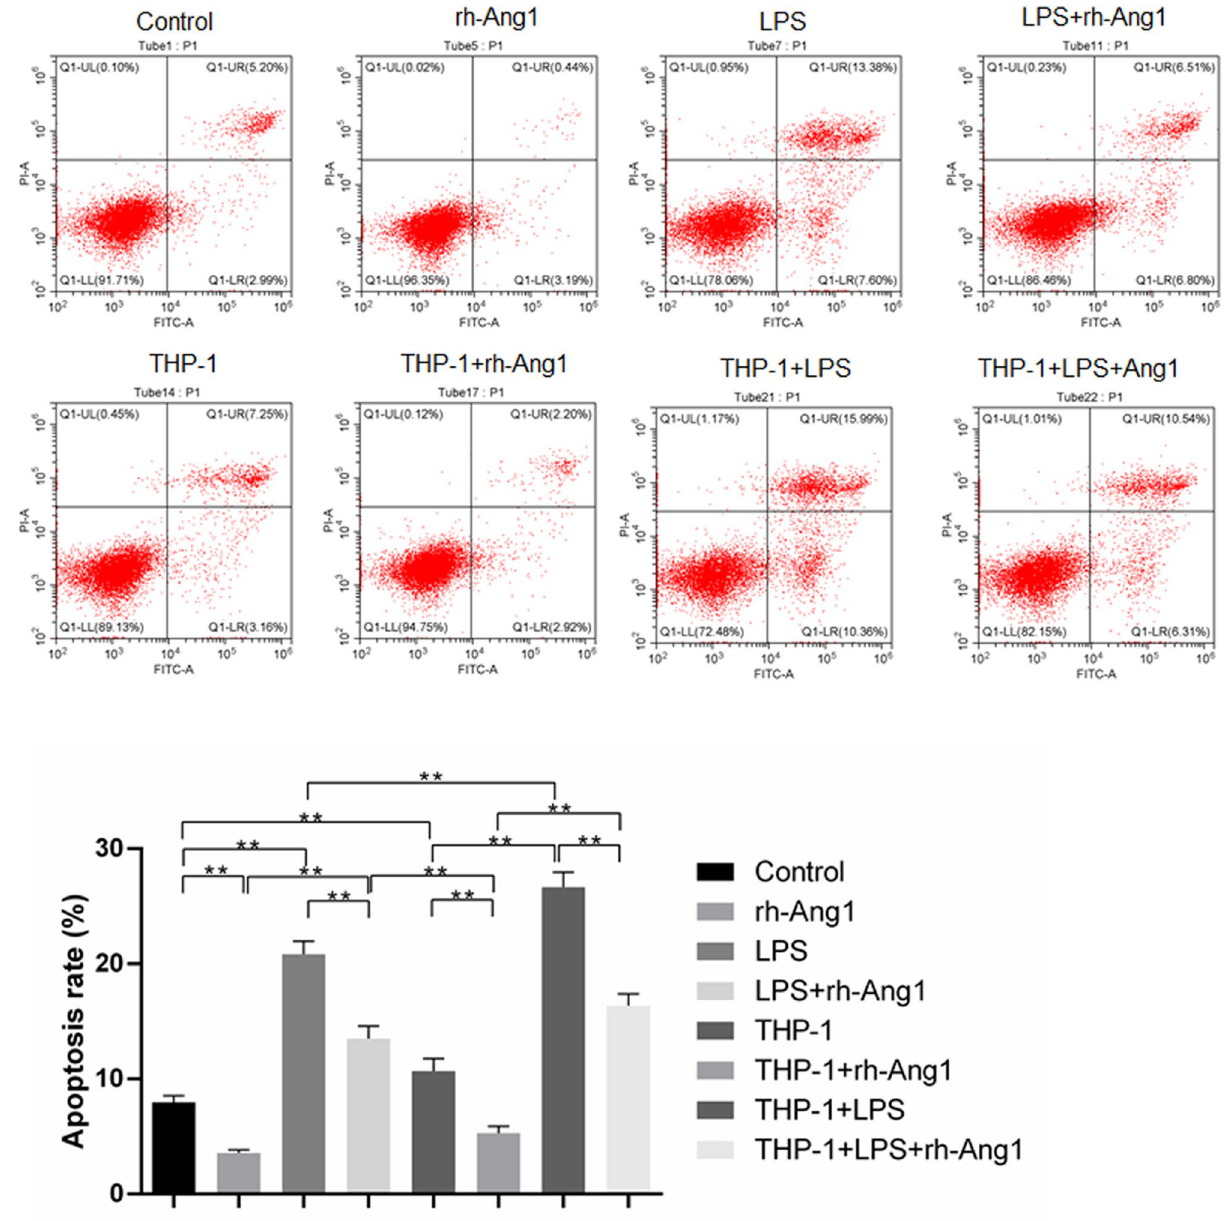
Figure 8. Ang1 significantly attenuated apoptosis of HUVECs under various conditions. Ang1 were used as a final concertation of 250 ng/mL. HUVECs were cultured alone with/without LPS (100 μg/mL) for 8 h, or co-cultured with THP-1-derived macrophages with/without LPS (100 μg/mL) for 8 h. Apoptosis of HUVECs was quantitated by Annexin V and PI staining via flow cytometry. Annexin V + cells are considered as apoptotic cells. n = 3 for each group. Data are expressed as mean ±